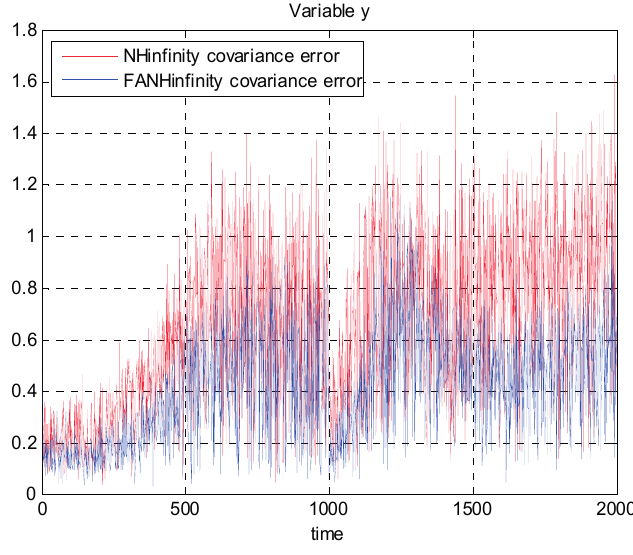
Figure 18. Error covariance in y -axes using the true error.